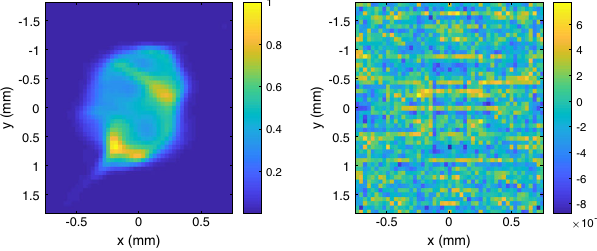
FIG. 8. Left: typical beam image at SCR-03 (the observation point) for one point in a quadrupole scan. The image recon- structed from the four-dimensional phase space density found using Eq. (36) extended to two degrees of freedom (projecting the phase space density ψ into co-ordinate space) is visually indis- tinguishable from the observed image. Right: residuals of the fit, representing the difference between the intensity of each pixel in the observed image, and the intensity of the corresponding pixel in the image reconstructed from the four-dimensional phase space density. The beam image (left) is scaled so that the intensity varies between 0 (dark blue) and 1 (yellow); on this scale, the largest residuals (right) are of order 10 − 7